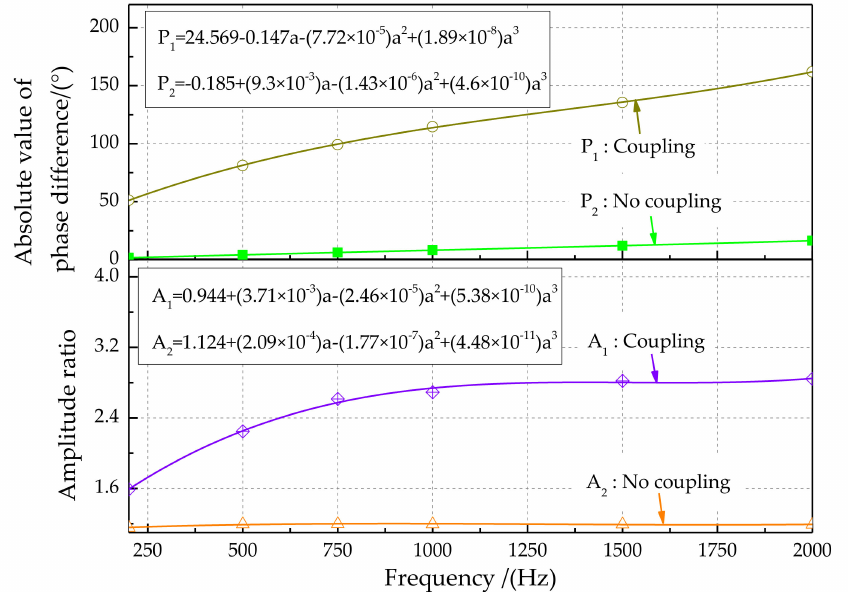
Figure 20. Phase difference and amplitude ratio characteristics of output signals for different sound source